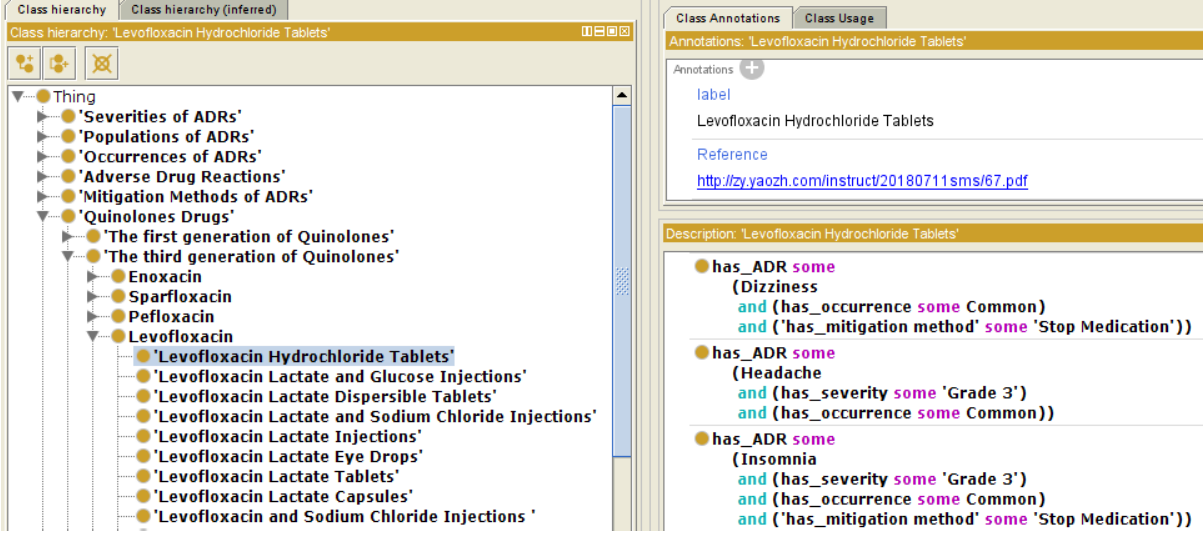
Figure 5. Ontology visualization using levofloxacin hydrochloride tablets as an example. ADRs: adverse drug